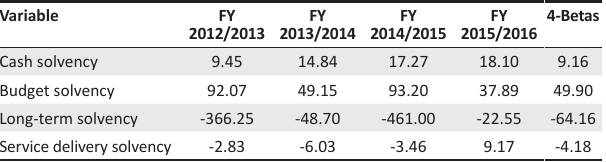
FIGURE 3: Calculation betas over the 4 years: 2012/2013–2015/2016. TABLE 2: Coefficients of financial